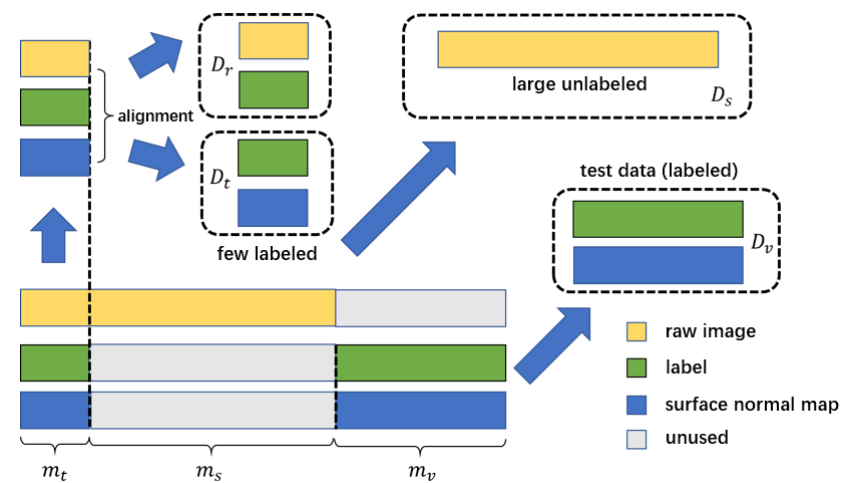
Figure 5. The datasets used in the